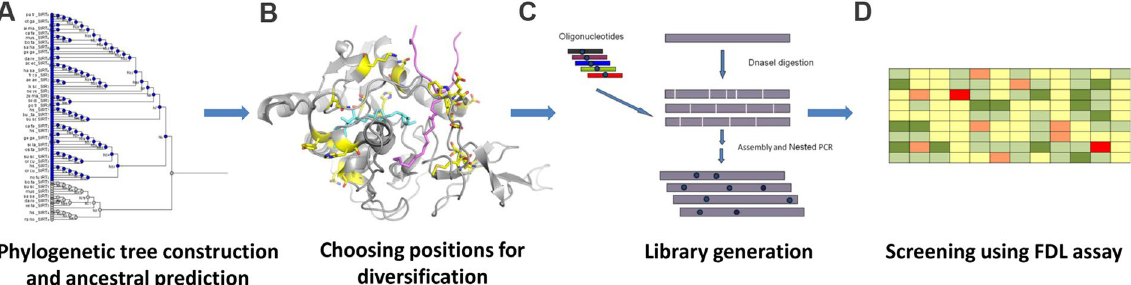
Figure 1. Scheme describing the directed evolution process for the generation of SIRT6 mutants with enhanced catalytic activity. The process includes: ( A ) The generation of phylogenetic tree and the prediction of ancestral SIRT6 sequences, ( B ) Selecting positions for diversification based on the distance from the catalytic H133 residue (see Supplementary Table S1 for the list of mutations), ( C ) Generation of ancestral library by spiking of nucleotides containing mutations such that each variant contains 3–5 mutations from the 27 possible substitutions selected, ( D ) Screening of the SIRT6 library in a 96-well plate format using the FDL assay with TNF- α myristoylated